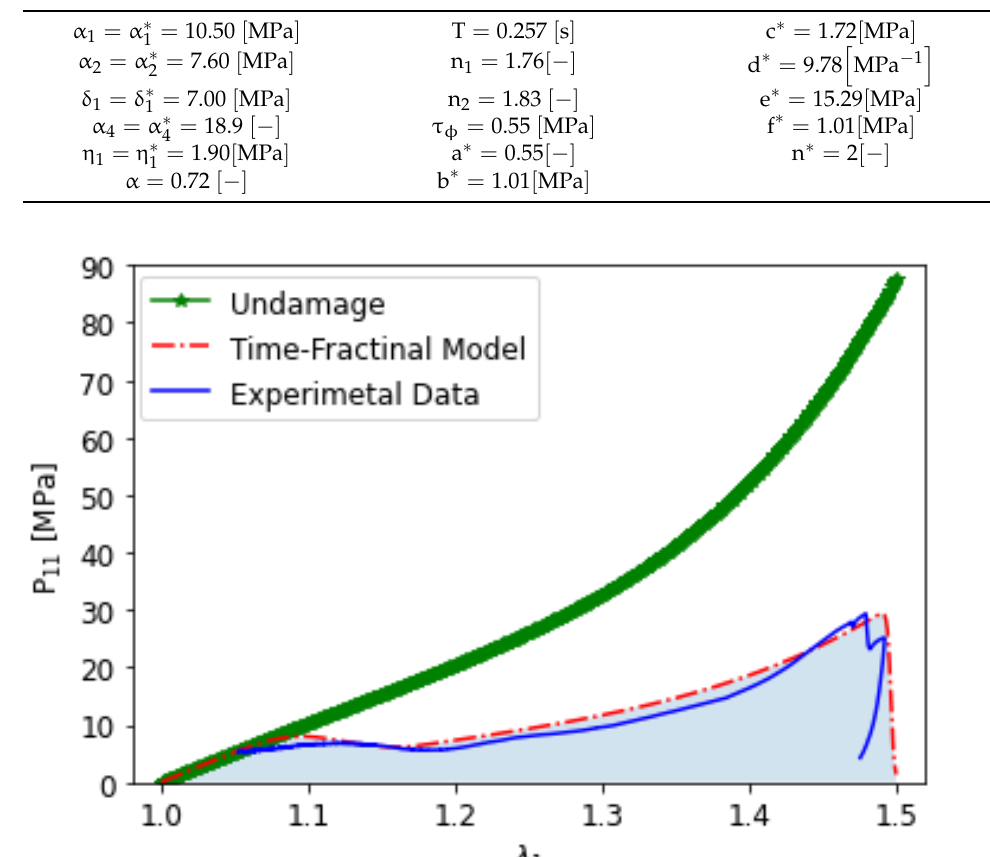
Figure 7. Comparison of experimental data (orange line) with HTFD model predictions (blue line) is contrasted with purely elastic (undamaged; τ φ → ∞ ) case (green line).